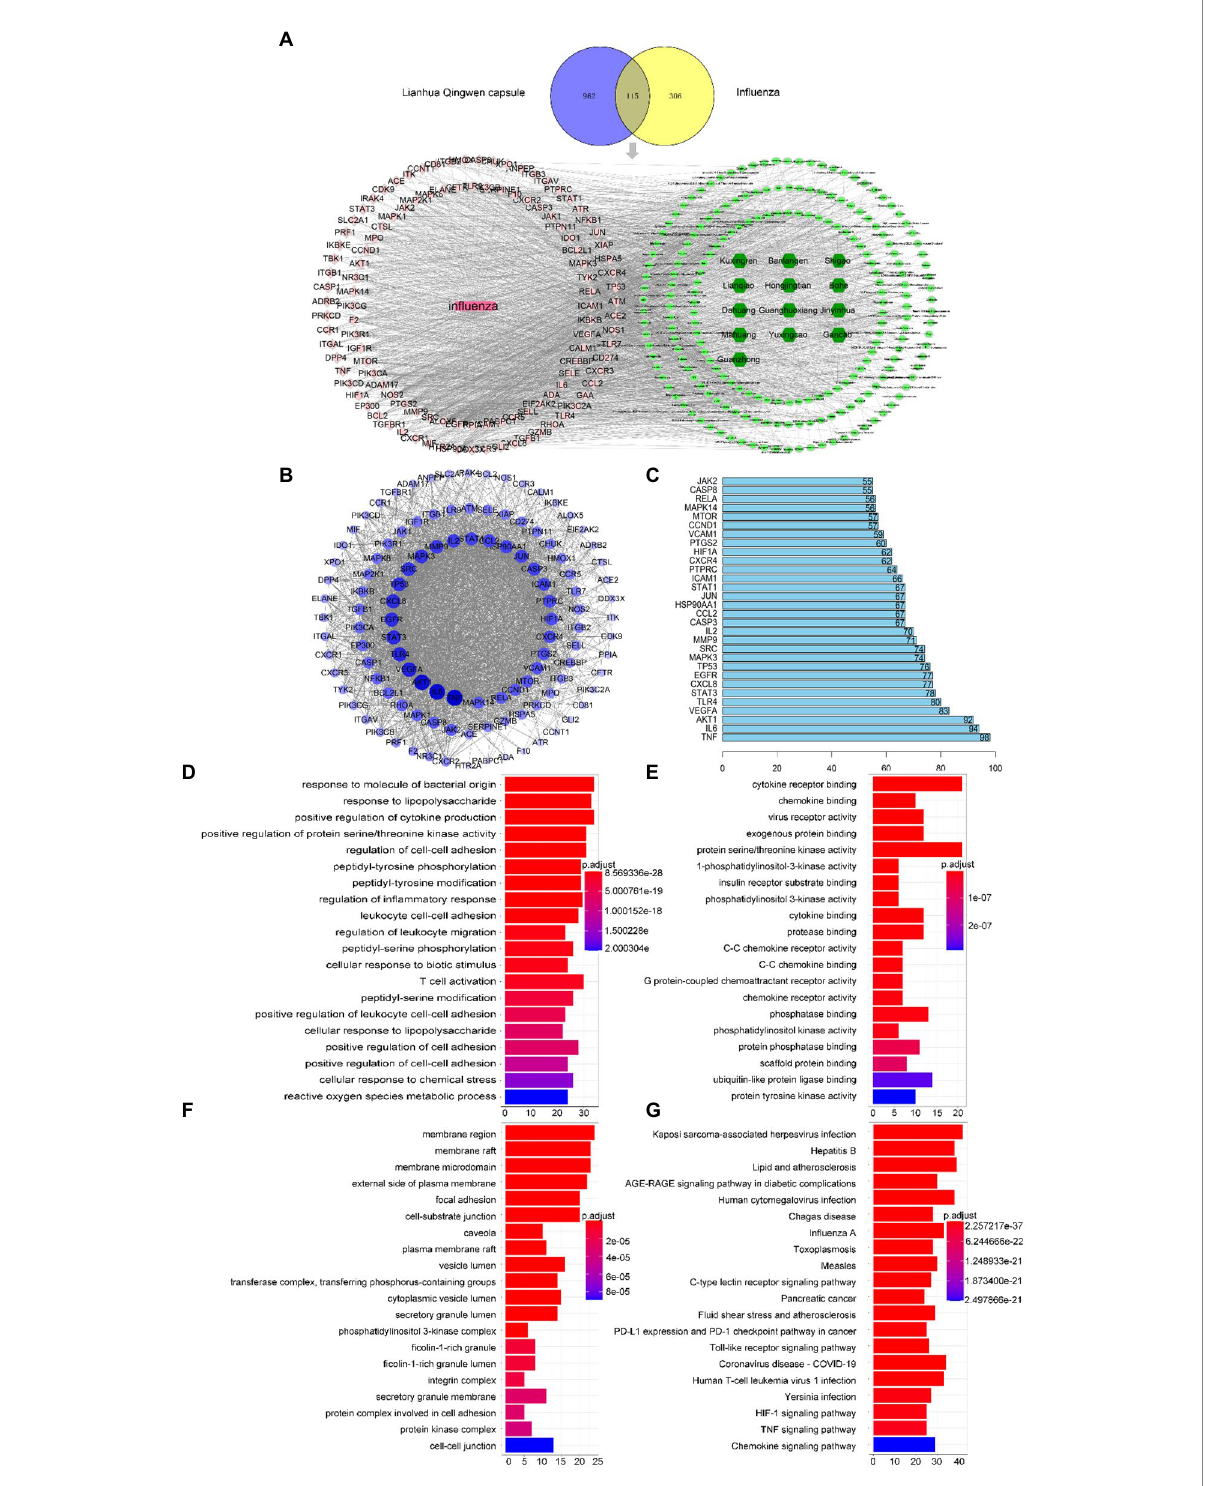
FIGURE 4 Network pharmacology screening results. (A) Drug disease comm“n target Wayne diagram and “d”ug component target disease” network diagram. Dark green, light green, pink, and rose red represent drugs, 204 active components in LHQW, 115 common targets, and diseases, respectively. (B) PPI network diagram of protein interaction. (C) Ranking of core targets based on PPI topology analysis (degree ranks the top 30). GO enrichment analysis of LHQW-treated influenza virus: ( © Biological process (BP); (E) Cellular component (CC) ; (F) Molecular function (MF). (G) The top 20 signaling pathways in the KEGG enrichment